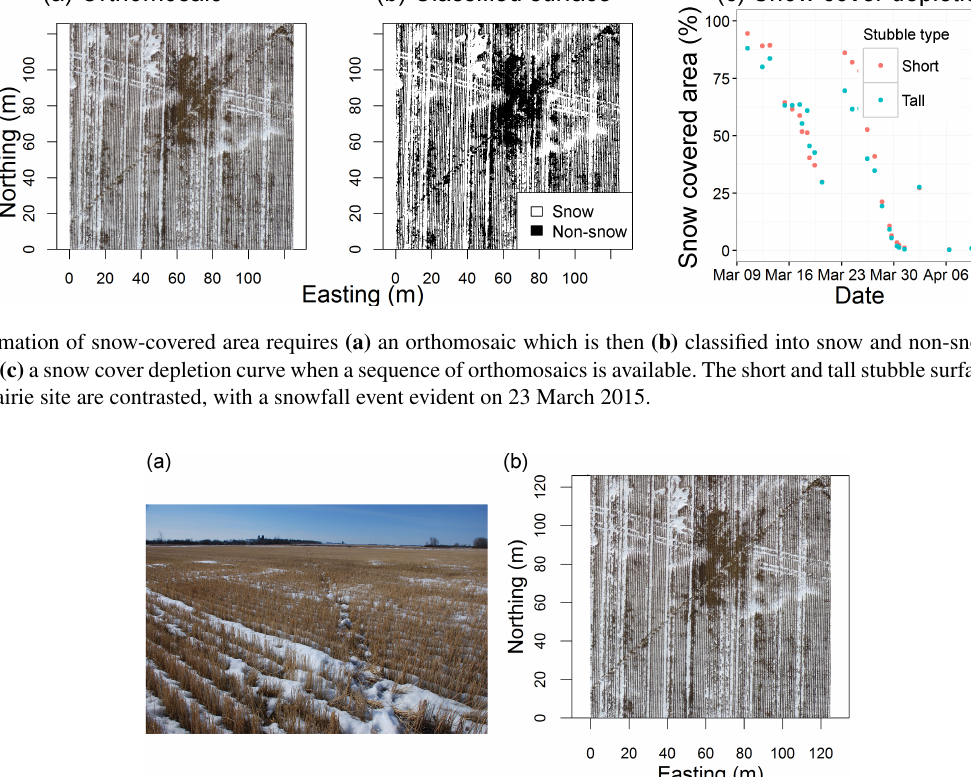
ments, mountain and prairie, to verify its ability to